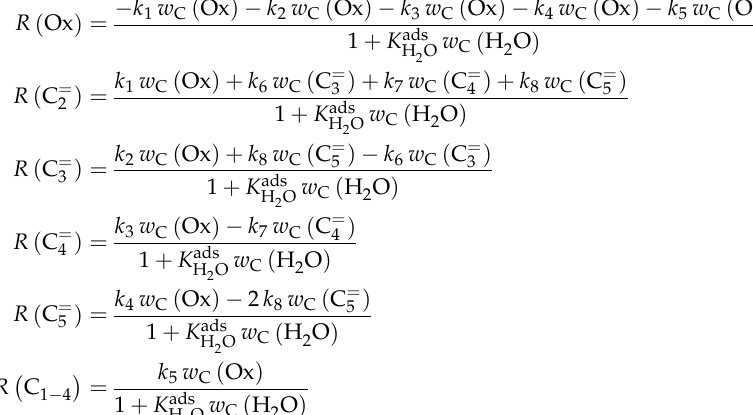
Scheme 28. Net rates of production of the different lumps for the model by Gayubo et al. [255] over SAPO-34 (six lumps); the Ox lump (methanol plus DME) is calculated via conservation of mass within the model.